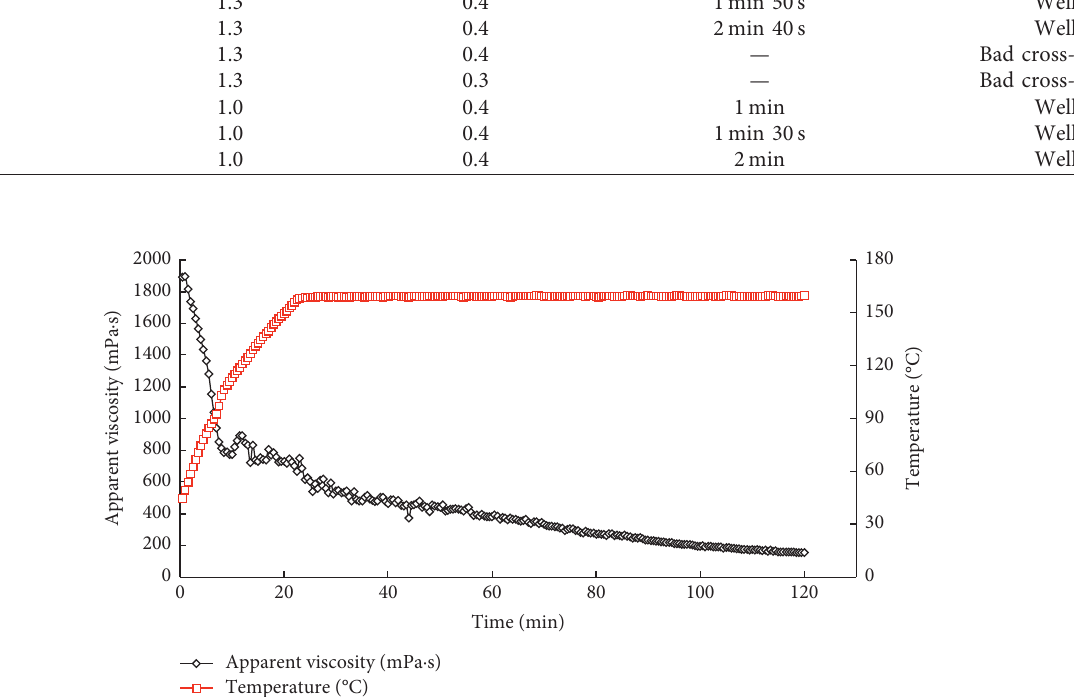
Figure 4: Temperature and shear resistance of the high-density fracturing fluid of formula